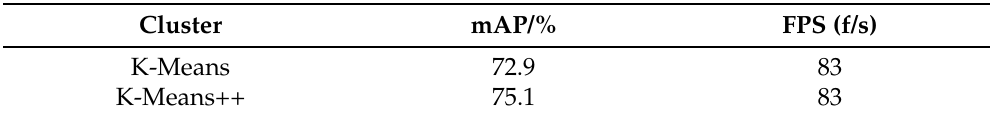
Table 3. Comparison of two clustering algorithms.